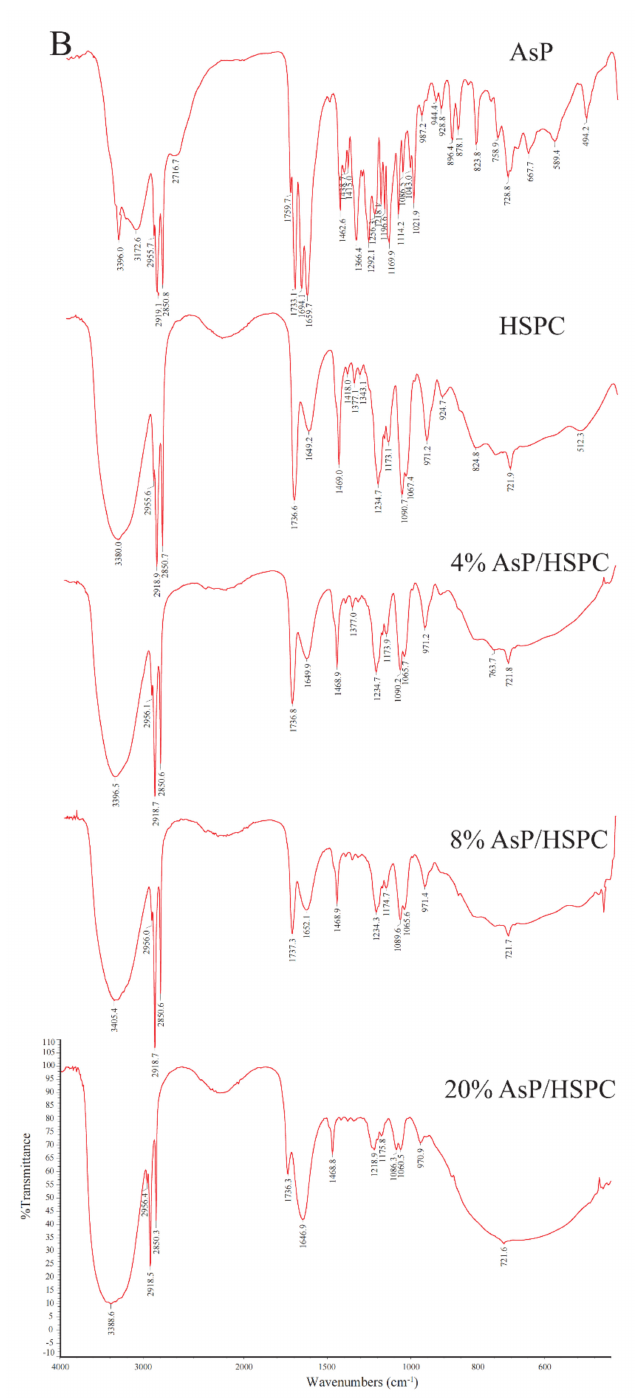
Figure 6. FTIR spectra of AsP and HSPC, and those of AsP–PC composites with various AsP/HSPC ratios (4%, 8%, 20%, w / w ): ( A ) dry form; ( B )